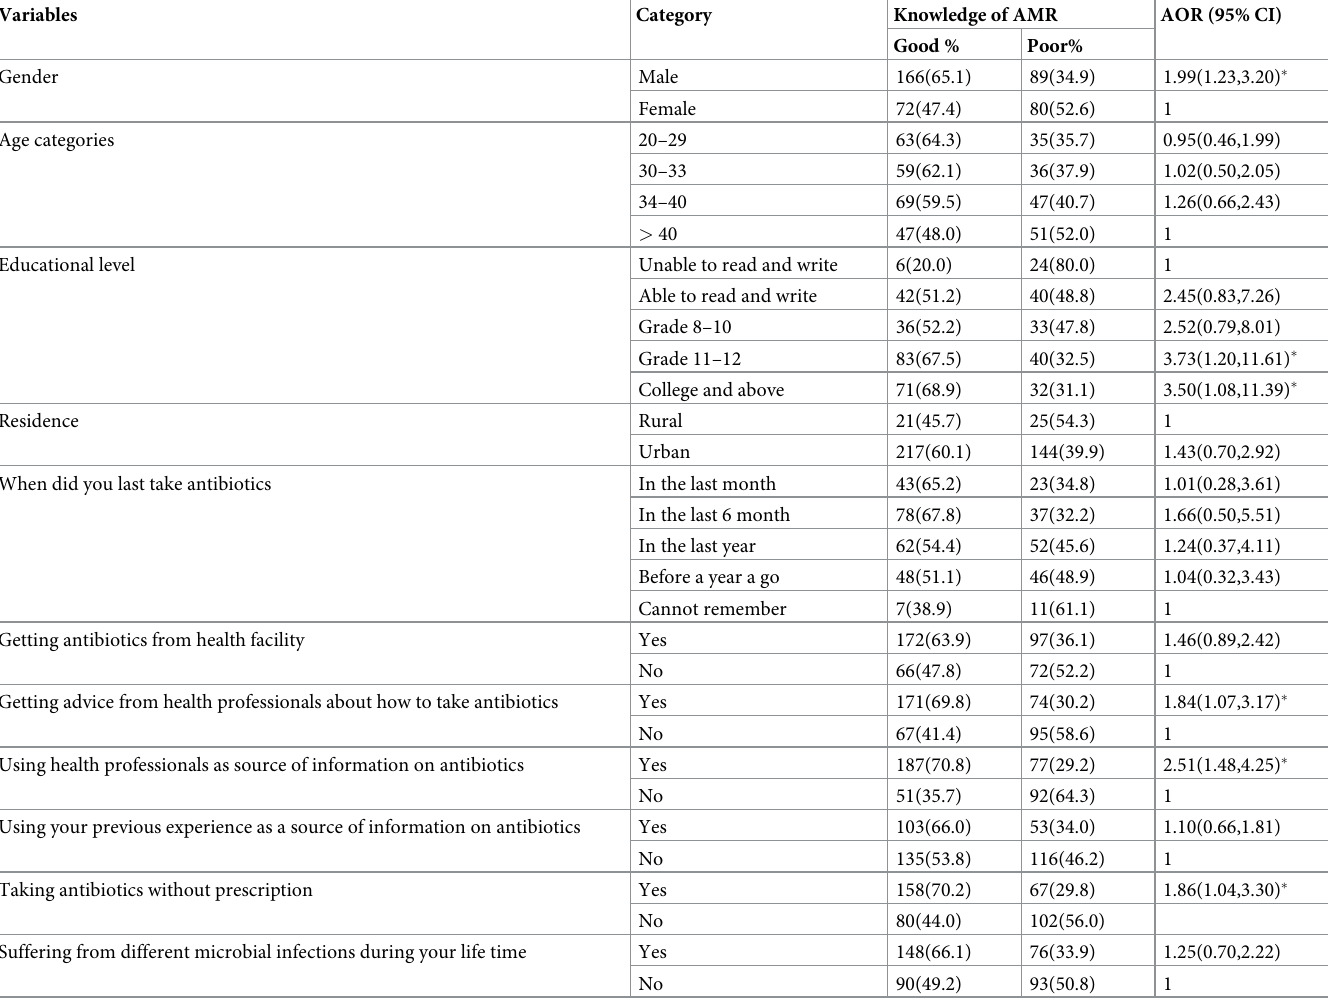
Table 4. Association factors of knowledge towards AMR among the adults of Dessie City, Northeast Ethiopia, 2021 (n =